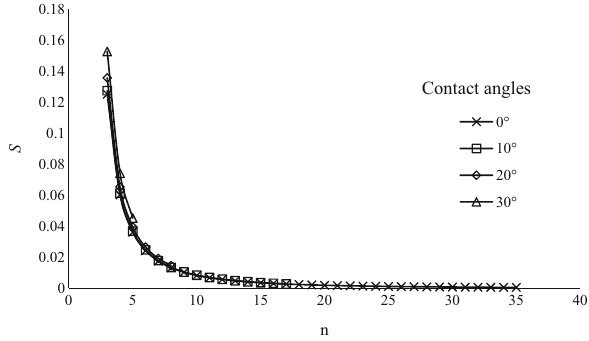
Fig. 6 Wetting phase saturation, S , for different equilateral polygons for four contact angles